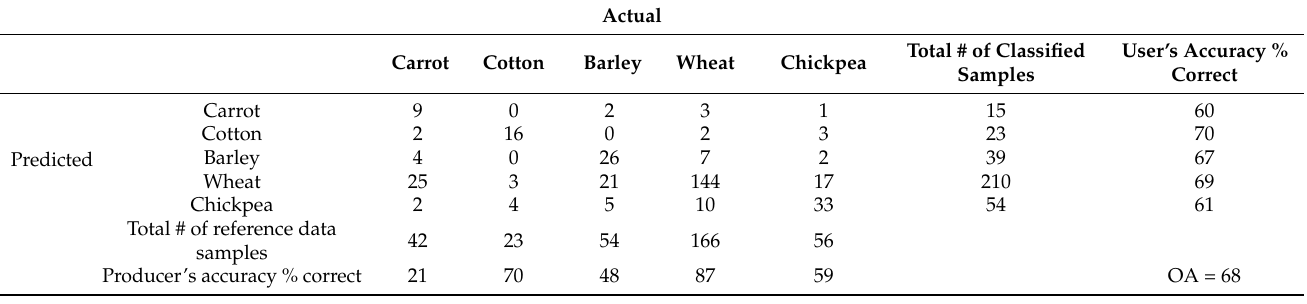
Table 4. Confusion matrix and validation results for NDII time series and XGBoost classifier.